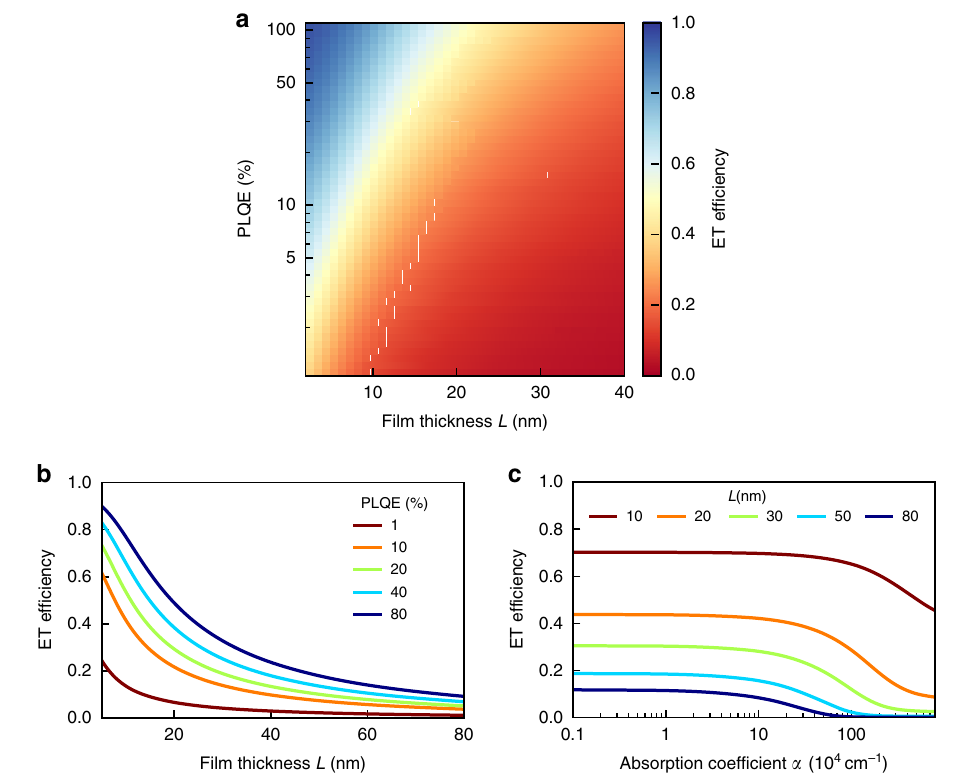
Fig. 3 Modelled ET ef fi ciency between a semiconducting charge-transport layer and a MAPbI 3 layer. ET ef fi ciency as a function of the PLQE, fi lm thickness and absorption coef fi cient of the CTL. a False-colour plot indicating the ef fi ciency of ET between a photoexcited CTL and a MAPbI 3 layer underneath, as a function of organic CTL thickness L and PLQE. b ET ef fi ciency as a function of semiconductor CTL thickness L for distinct PLQE values, and absorption coef fi cient α ( λ exc ) = 13 × 10 4 cm − 1 . c ET ef fi ciency as a function of the CTL absorption coef fi cient α ( λ exc ) at the excitation wavelength, for different fi lm thicknesses and a value of 50% PLQE. Additional false-colour plots mapping out this parameter space with wider ranges are shown in Supplementary Fig.